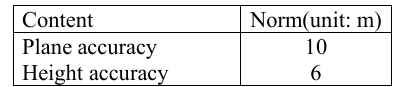
Table 3. Norm requirements of absolute orientation